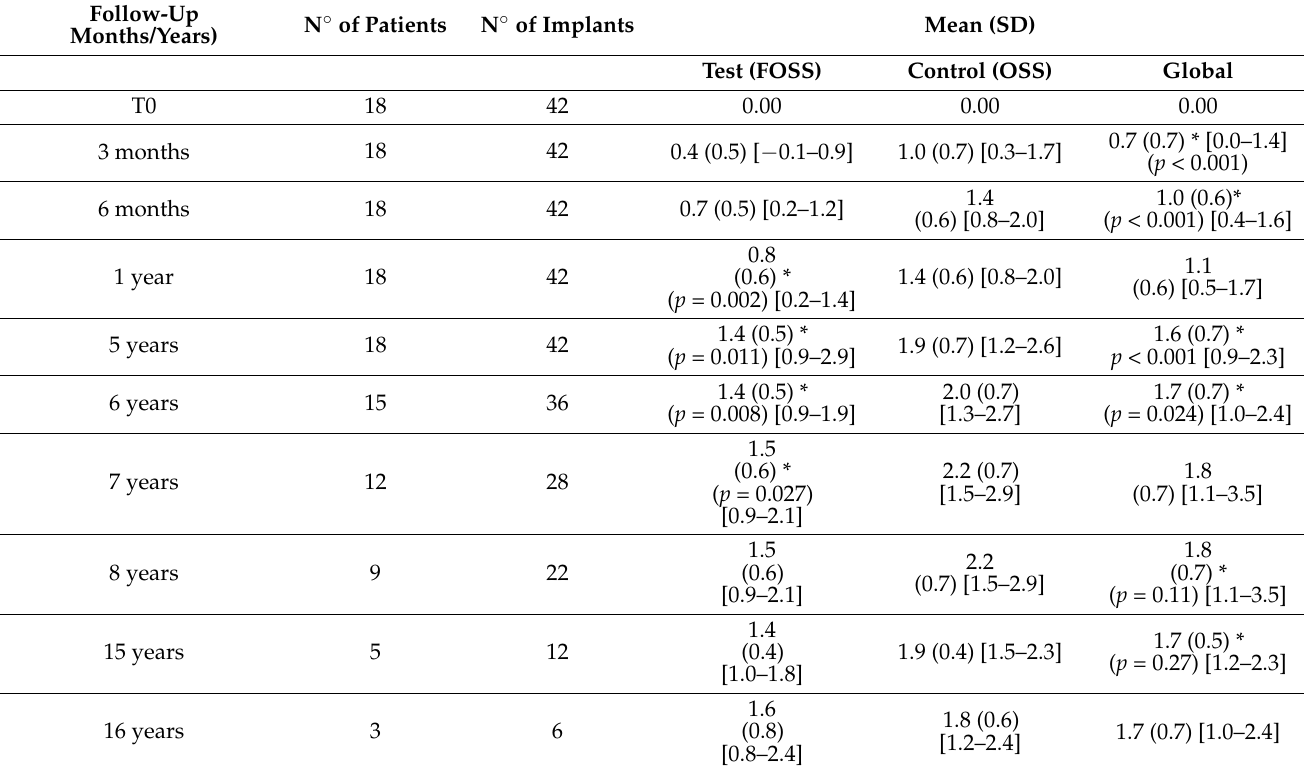
Table 2. Interproximal BLC (mm) over time for OSS and FOSS implants (bone resorption was expressed in positive values). The (*) refers to statistically significant